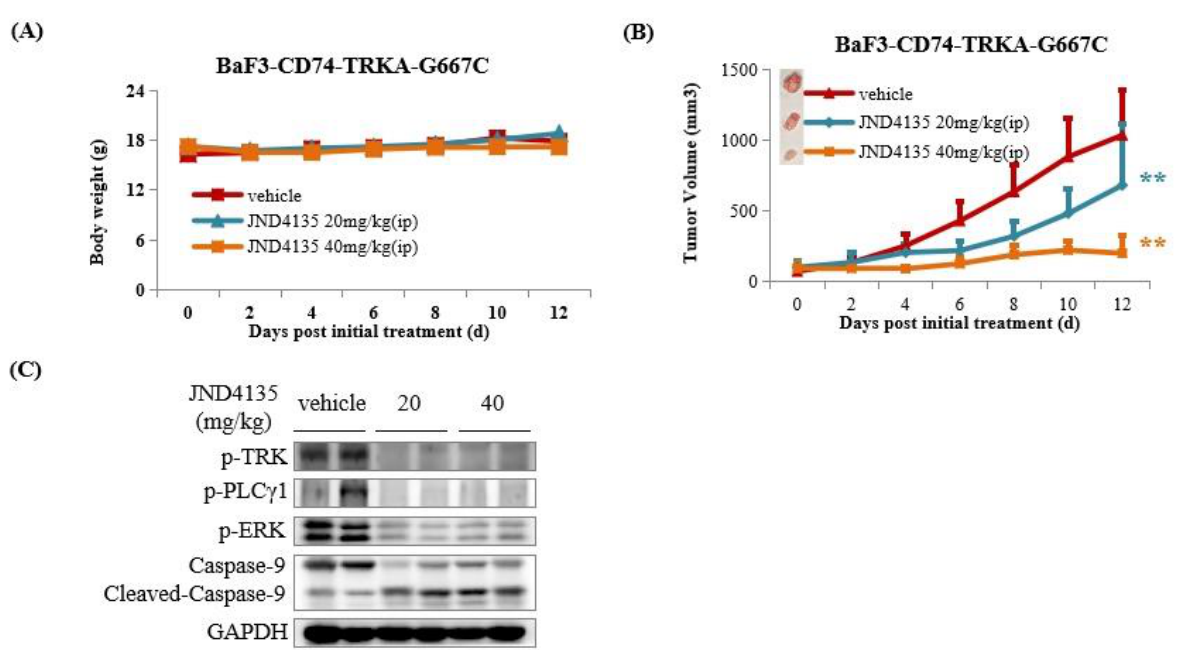
Figure 7. JND4135 overcomes BaF3-CD74-TRKA-G667C mutant resistance in vivo. ( A ) Antitumor efficacy of JND4135 in BaF3-CD74-TRKA-G667C xenograft mouse model. ( B ) Effect of JND4135 on body weight of BaF3-CD74-TRKA-G667C xenograft mouse model. ( C ) Effect of JND4135 on TRK signaling pathway in tumor tissues. Mice were intraperitoneally administrated JND4135 (20 and 40